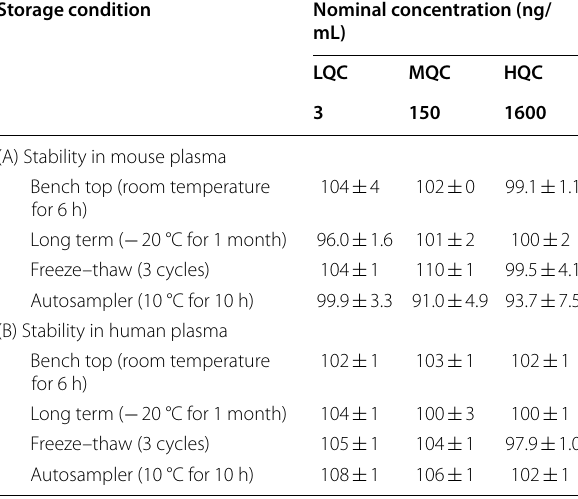
Table 3 Stability of alpelisib in mouse and human plasma (mean SD, n ± =